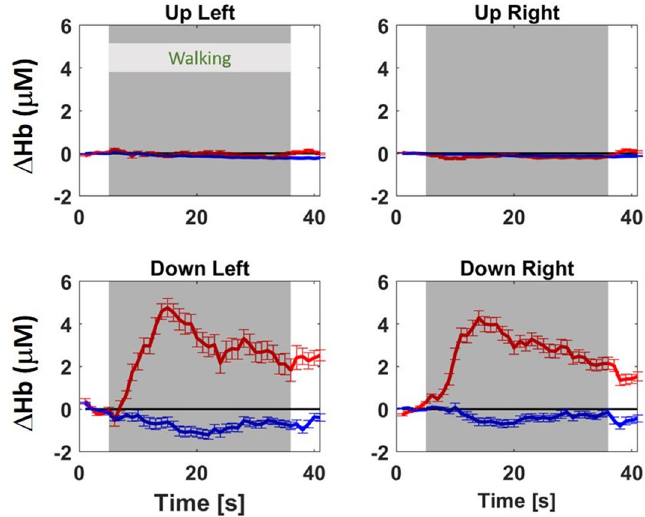
Figure 1. Group-average of [ΔO 2 Hb] (red lines) and [ΔHHb] (blue lines), in μM, and their standard deviation during the motor task for extra-cerebral (up) tissue (top row) and cerebral (down) tissue (bottom row) and for the left (left column) and right (right column) hemisphere. In every plot, the first 5 s are the baseline (sheep stand still), followed by 30 s walking (marked as gray area), and finally 5 s recovery period (sheep stand still). The horizontal black line in every sub-figure indicates the zero value.